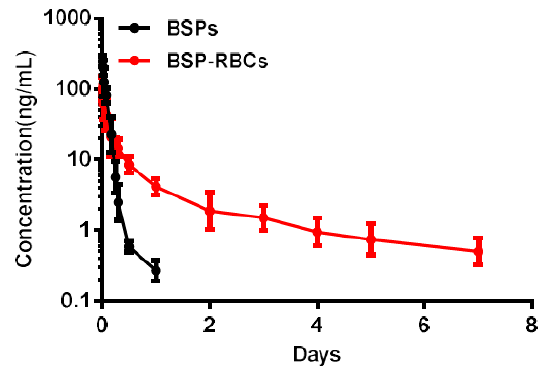
Figure 7. Pharmacokinetics of NRBCs and BSP-RBCs. Data are represented as mean ± SD, six samples were used in each group. Table 1. Summary PK parameters for betamethasone. (mean ± SD, n = 6).